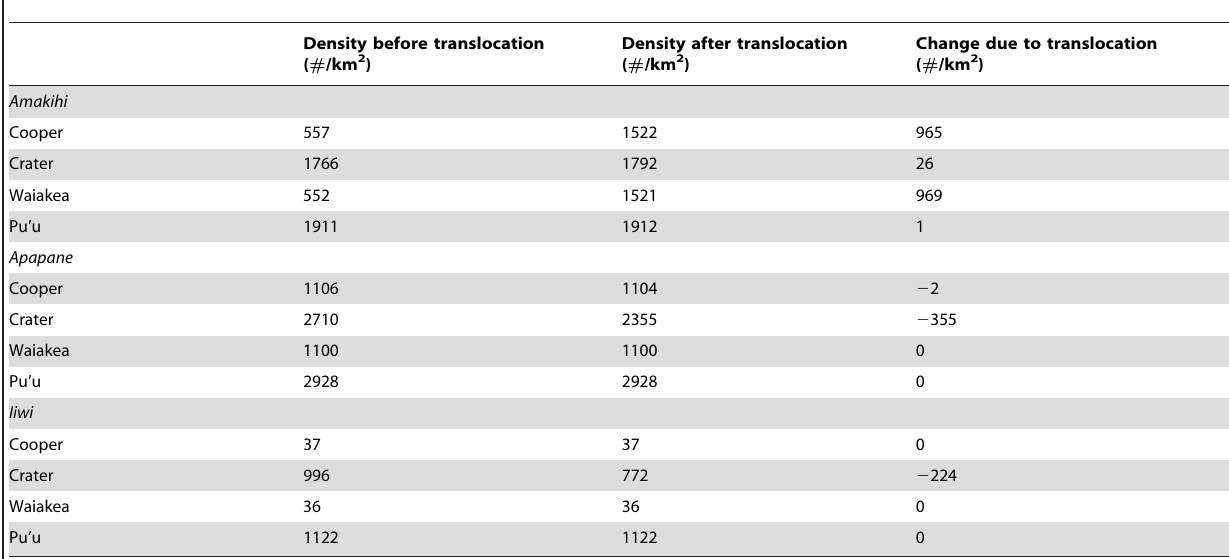
Table 2. The change in the mean annual model estimated densities of three Hawaiian honeycreeper species due to the translocation of disease-resistant Amakihi from low elevation to the mid-elevation sites Cooper, Crater, Waiakea and Pu’u.